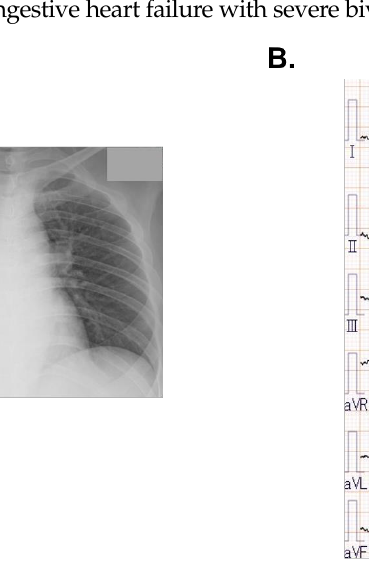
Figure 1. Chest X-ray on admission showed cardiomegaly and mild pulmonary congestion ( A ). Electrocardiogram showed sinus rhythm with no ST-segment elevation ( B ).